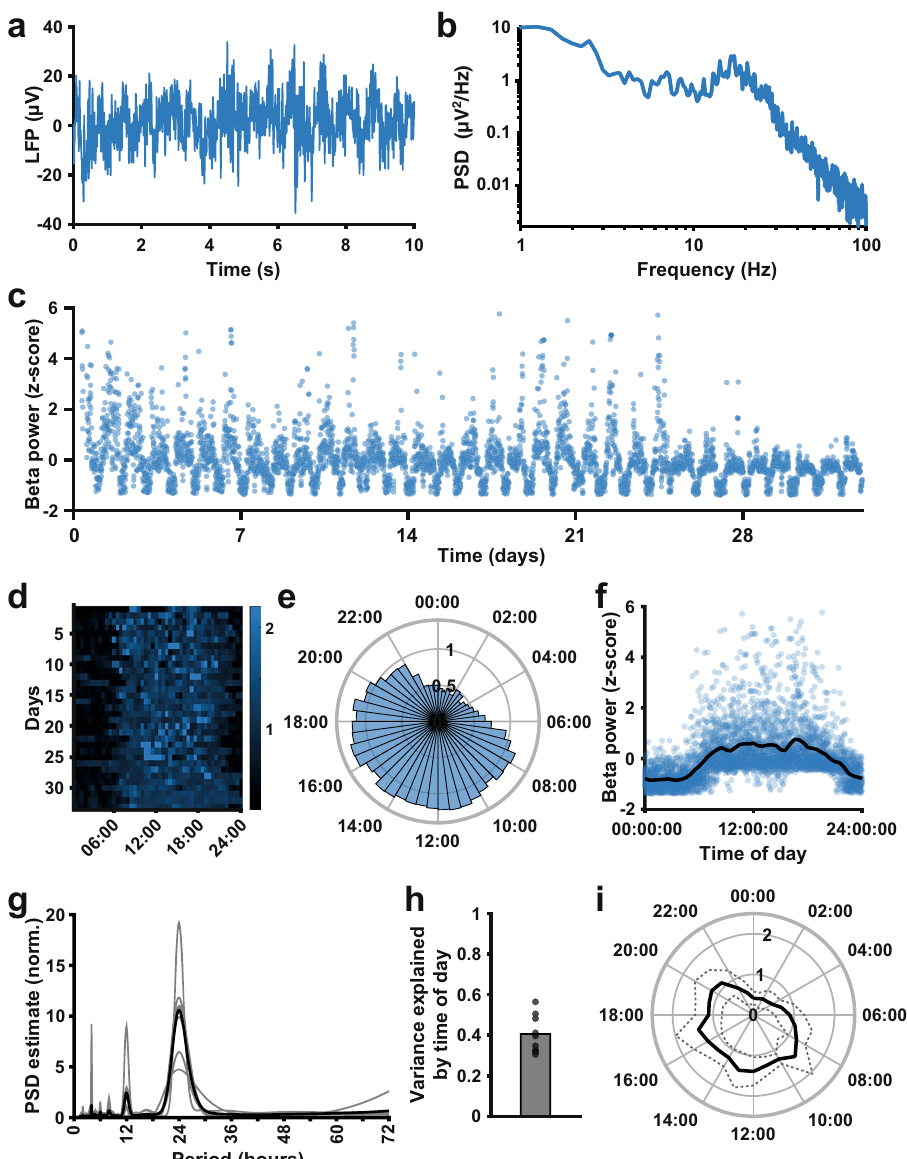
Fig. 1 Beta oscillatory power measured with the Percept DBS device shows a consistent diurnal pattern with decreased beta during the night. a A 10-s LFP recording from the STN of a Parkinson ’ s disease patient implanted with the Medtronic Percept DBS device, acquired during the BrainSense signal test. b Power spectrum of the LFP segment in a (obtained using Welch ’ s method) presented on a log-log scale, showing a peak in the beta frequency range. c Mean STN peak-to-peak beta power (µVp, sampled every 10 min) over a 1-month period, from the same example STN (after outlier removal). d Heat map of beta power (detrended by normalizing each day to its median value) across the 24 h of the day for all days in the data collection period, for the same example STN. e Detrended beta power across the 24-h diurnal cycle generated from the data in d . For each day, the median beta power was calculated for each 30-min time bin, and the bar height in the circular bar graph represents the median across days. f Normalized beta power measurements plotted against the time of day the measurements were taken for the same example STN, showing a consistent daily pattern of beta power. The black line represents a linear fi t through the mean beta power for the time of day (means obtained by dividing the day into 30-min time bins). g Periodogram of the beta power signal for all STN (normalized; estimated using Welch ’ s method). The population mean (black) highlights a clear peak at a period of 24 h, which is present in all individual beta power time series (gray lines, n = 9). h The proportion of variance explained by time of day, estimated using fi ts such as illustrated in d , for all STN in the data set (mean 0.41 ± 0.092; n = 9; p < 0.001 for all-time series, temporal shuf fl ing test). i Mean (solid line) and standard deviation (dashed line) of detrended beta power around the diurnal cycle across all STN time series ( n = sleeping and waking epochs is consistent with previous compar- In our group of patients, STN beta power showed consistent isons of sleeping and waking beta activity in PD patients 20,22,23 diurnal fl uctuations at an individual patient level during contin- uous high-frequency DBS. Moreover, across patients, the beta was and con fi rms that beta power differences between sleeping and consistently increased during the day, and reduced during the waking remain prominent even under a regime of continuous night. The common pattern of beta modulation closely followed high-frequency DBS. This is in line with electrophysiological the estimated sleep schedule of patients. Such a contrast between recordings of STN LFPs showing that DBS reduces beta power